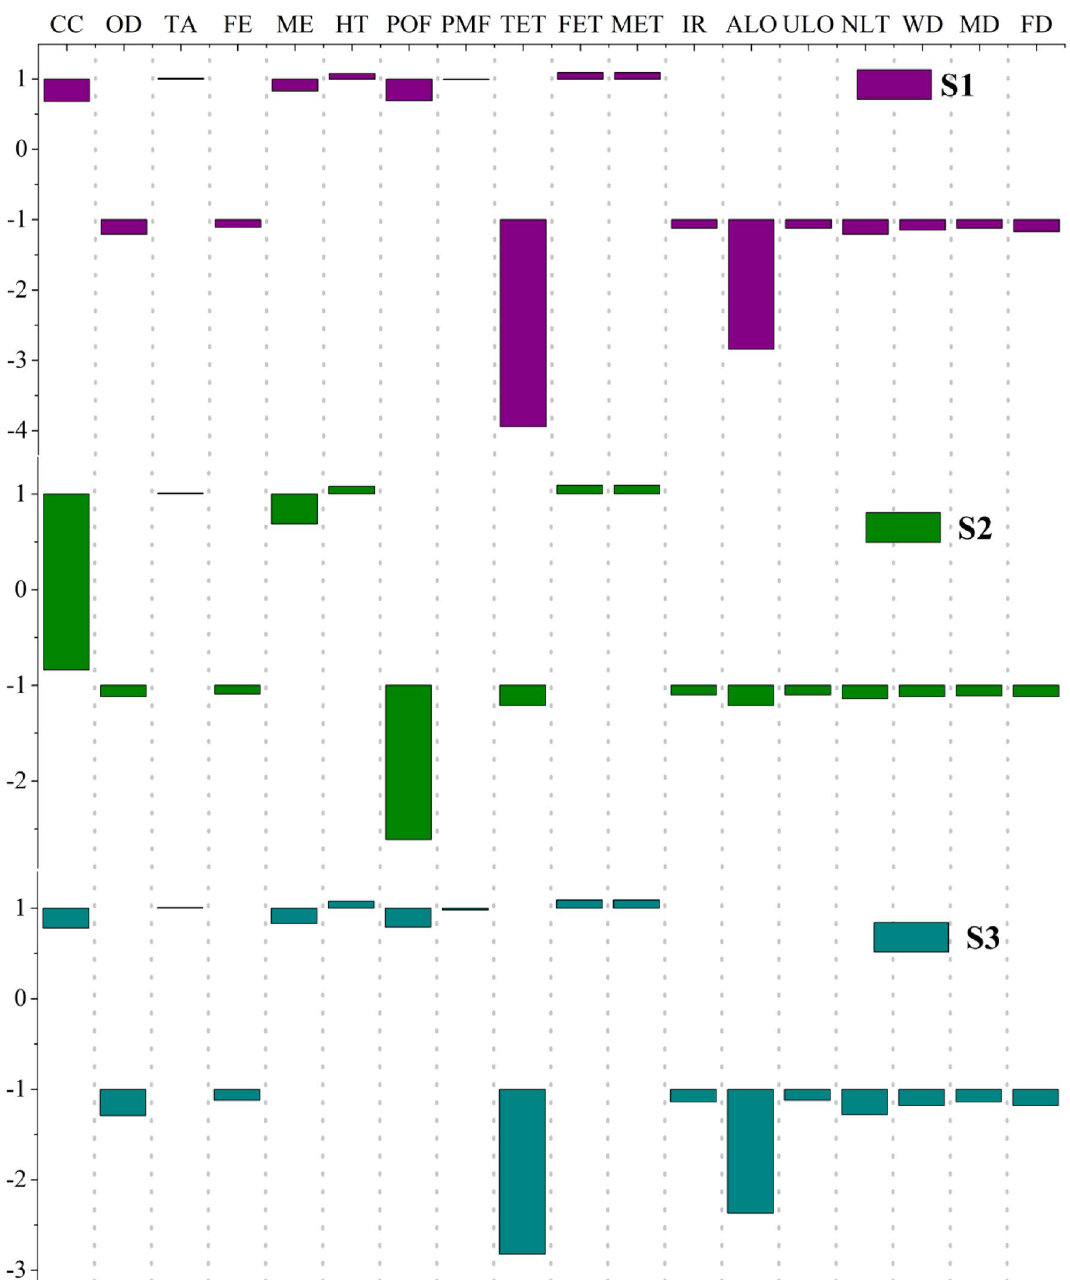
Figure 4. The sensitivity results of each system under various scenarios in ReCiPe assessment